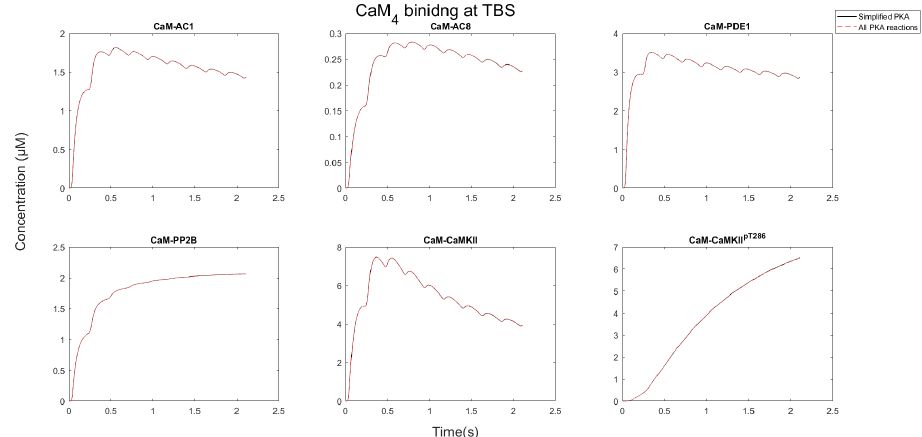
Figure 6. Quantity of CaM ‐ bound targets during 100 Hz stimulation. Notice that AC1/8 and PDE1 peak and then decrease as CaM 4 is redistributed away from AC1/8, whereas CaMKII continues to bind CaM 4 . This allows CaMKII to outcompete the ACs for CaM.